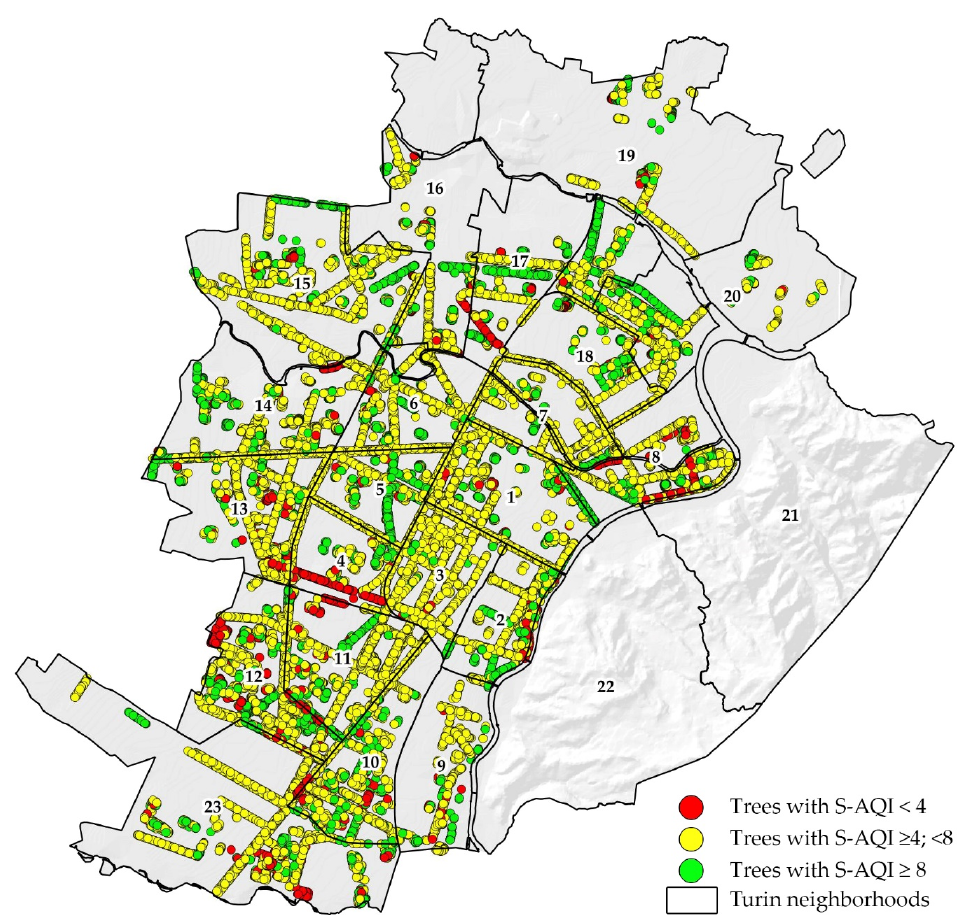
Figure 4. Trees present on Albera.To system classified by their S-AQI values.